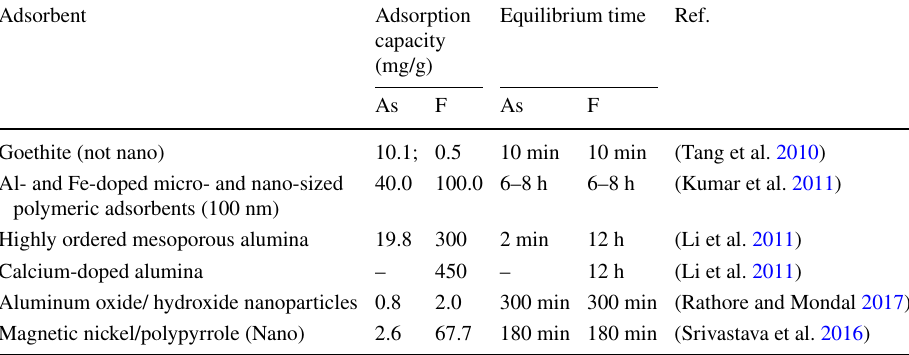
Table 1 Adsorption capacities and time required for combined removal of arsenic and fluoride using already reported adsorbents